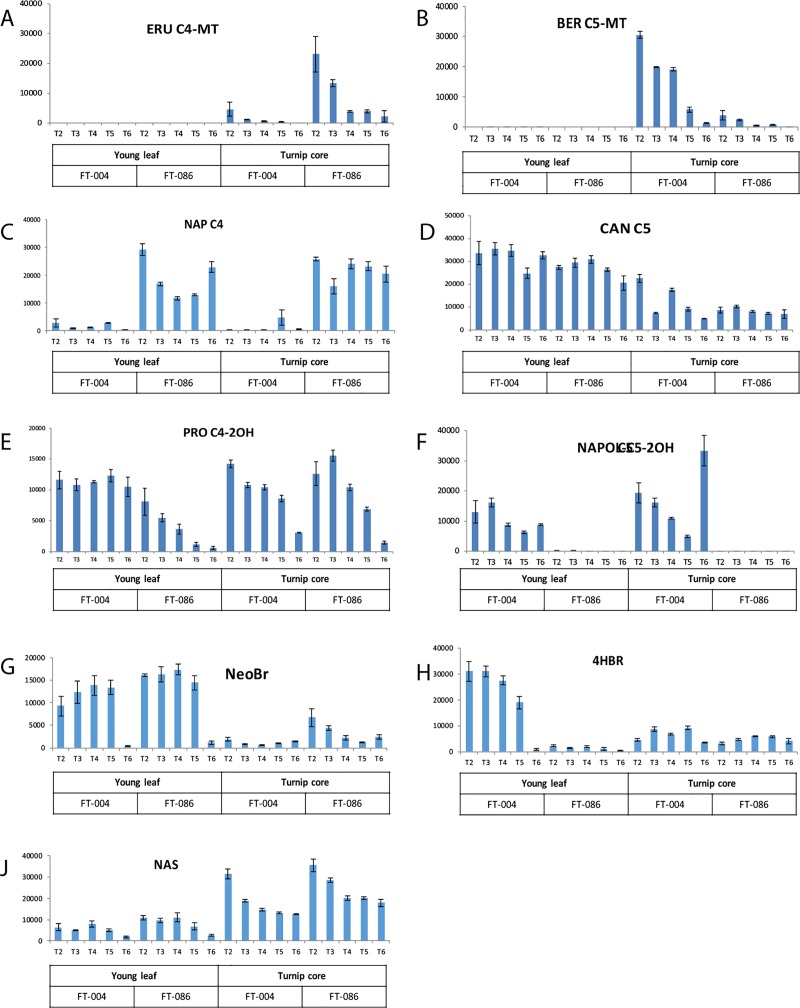
Relative quantity of individual GLS (A-J) in turnip tissues in FT-004 and FT-086 accessions.The Y-axis shows the peak surface area measured in LC-MS for the indicated compound. For timepoints see legend Fig 2. Error bars indicate standard deviation (n = 3).